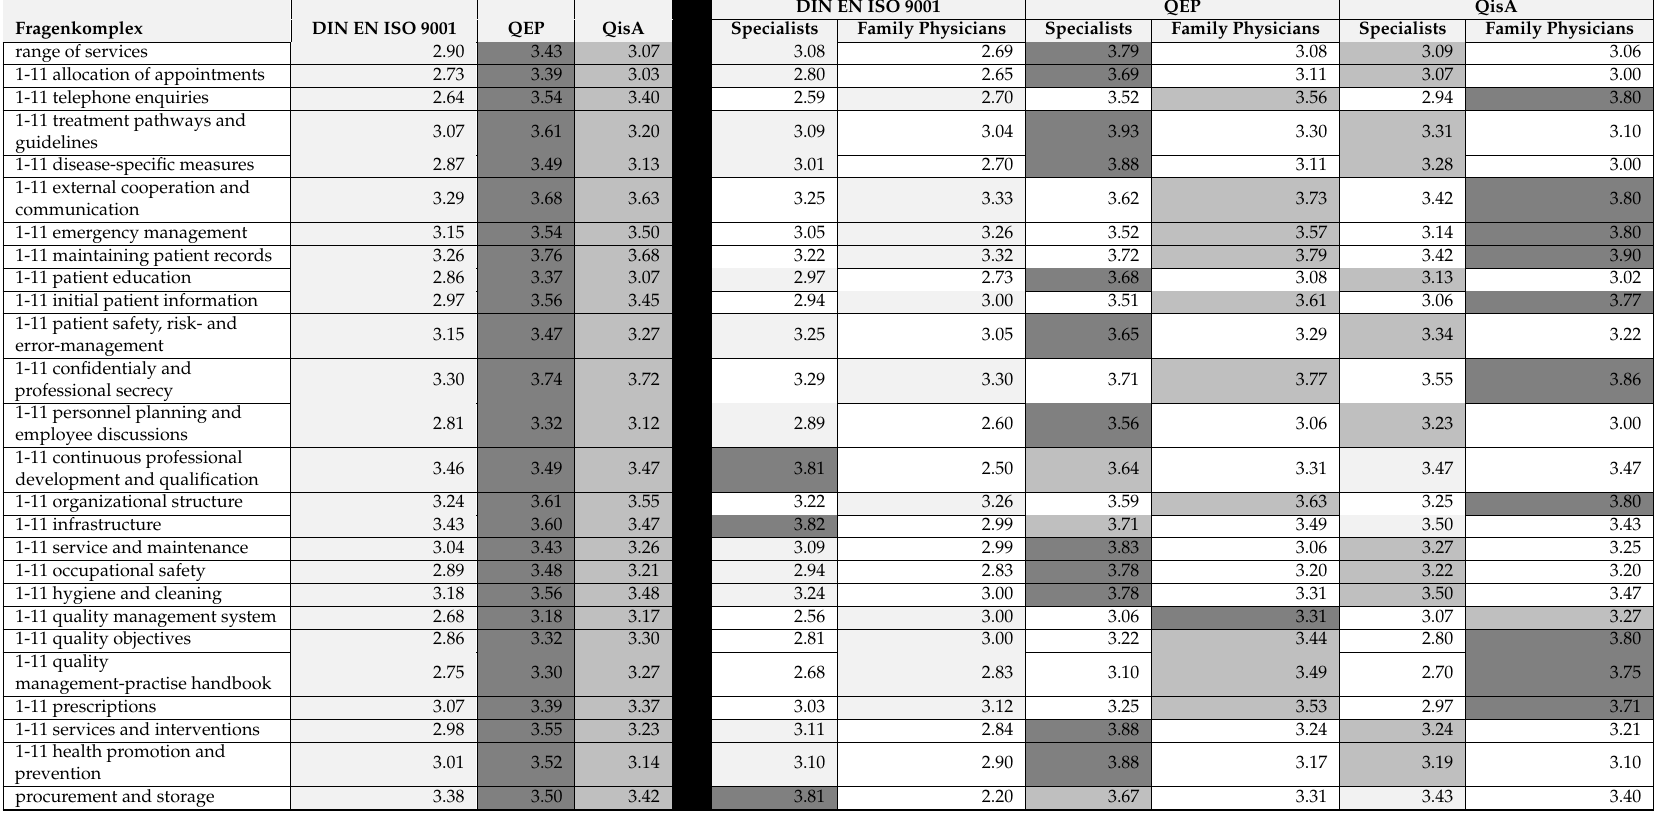
Table 2. Average scores of the quality management systems by quality categories and